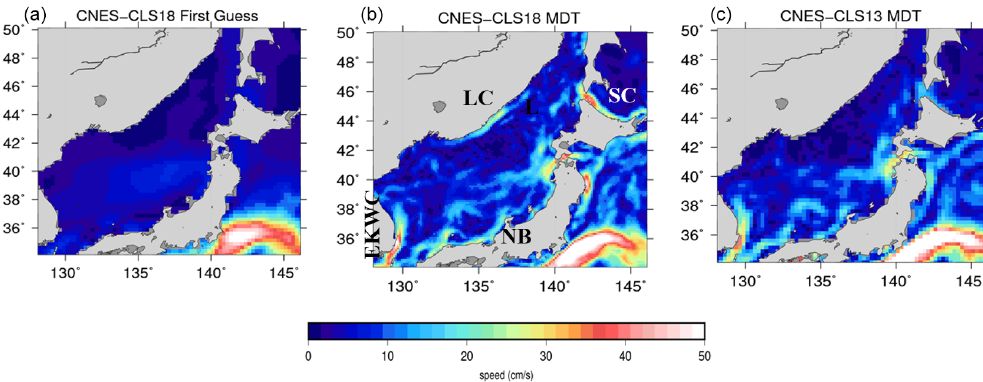
Figure 8. Mean geostrophic velocities in the Japan Sea in the CNES-CLS18 GOCE-based first guess (a) , in the CNES-CLS18 MDT (b) and in the CNES-CLS13 MDT (c) . Abbreviations for the main currents are as follows – LC: Liman Current; EKWC: East Korean Warm Current; NB: nearshore branch of the Tsushima Warm Current; and SC: Soya Current.